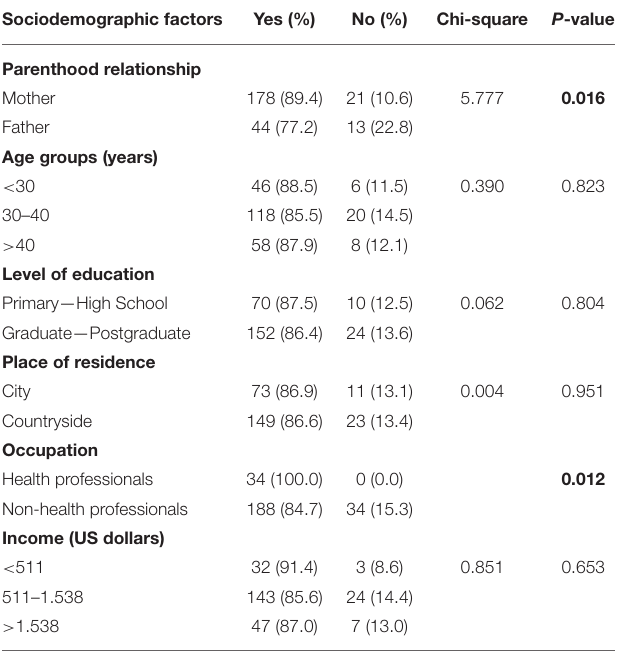
TABLE 4 | Statistical analysis of parents’ knowledge about COVID-19 transmission via air droplets during dental treatments based on sociodemographic factors.